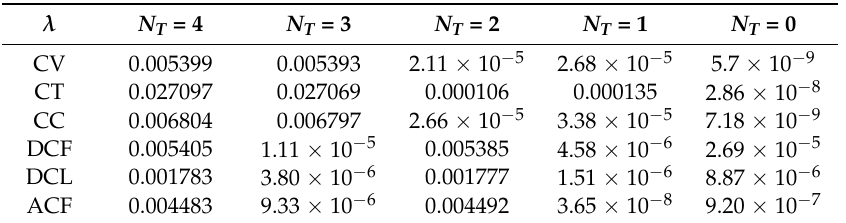
Table 4. Sensitivity analysis of failure parameters to state probability.